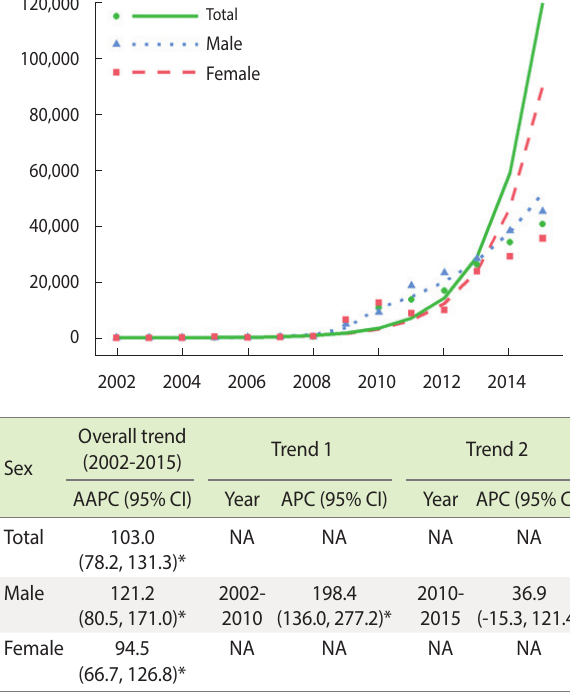
Figure 2. The age-standardized APC and AAPC of opioid prescrip- tions as milligram morphine equivalent per 10.000 registrants dur- ing 2002-2015 by sex. AAPC, average annual percentage change; APC, annual percentage change; CI, confidence interval; NA, not applicable.